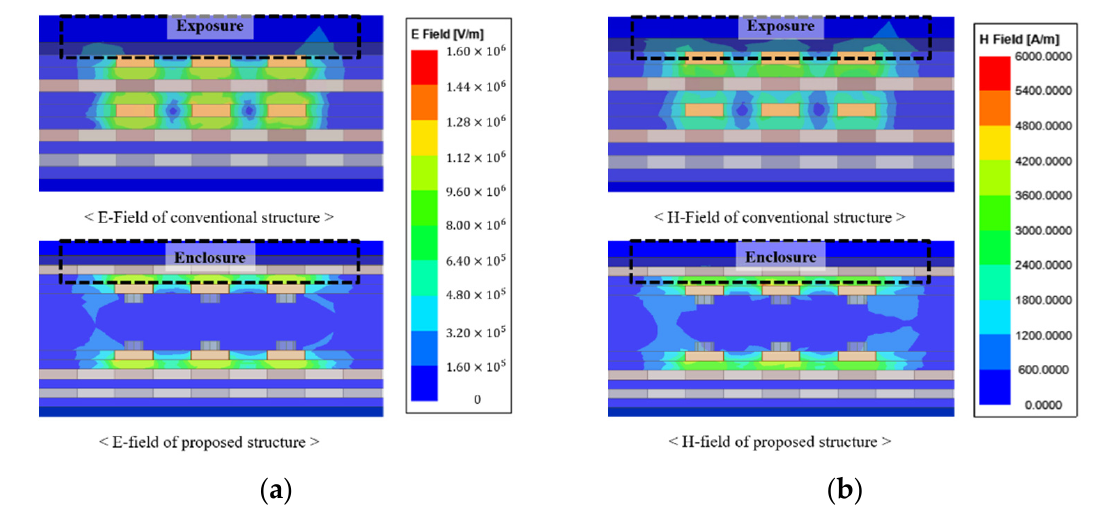
Figure 9. Field distribution of the proposed channel structure and conventional channel structure: ( a ) E-field and ( b ) H-field.